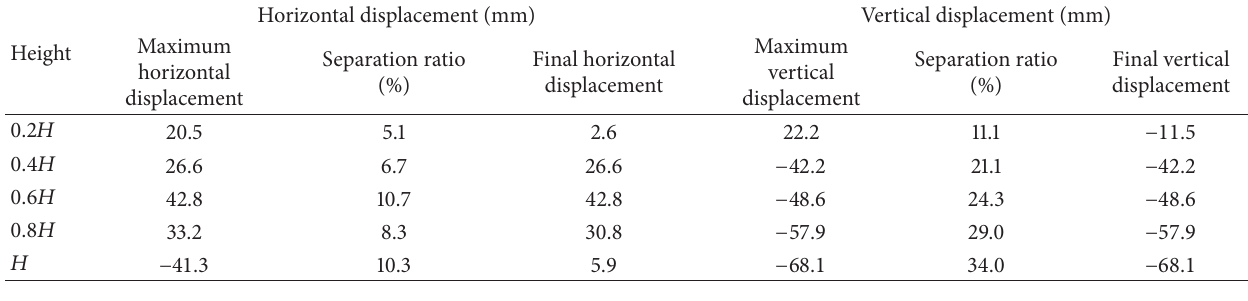
Table 6: Block displacement for 200 mm reinforcement spacing.